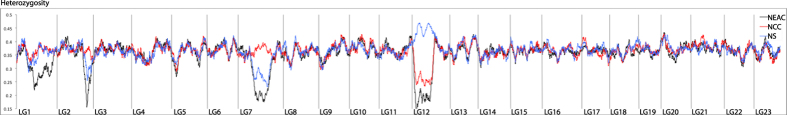
Heterozygosity level across all linkage groups in the Northeast-Arctic, Norwegian coastal and North Sea cod.SNPs are ordered according to linkage group and position within linkage groups. The observed heterozygosity pattern shows four distinct regions of the genome with distinctly different heterozygosity values. NEAC = Northeast Arctic cod, NCC = Norwegian coastal cod, NS = North Sea cod.